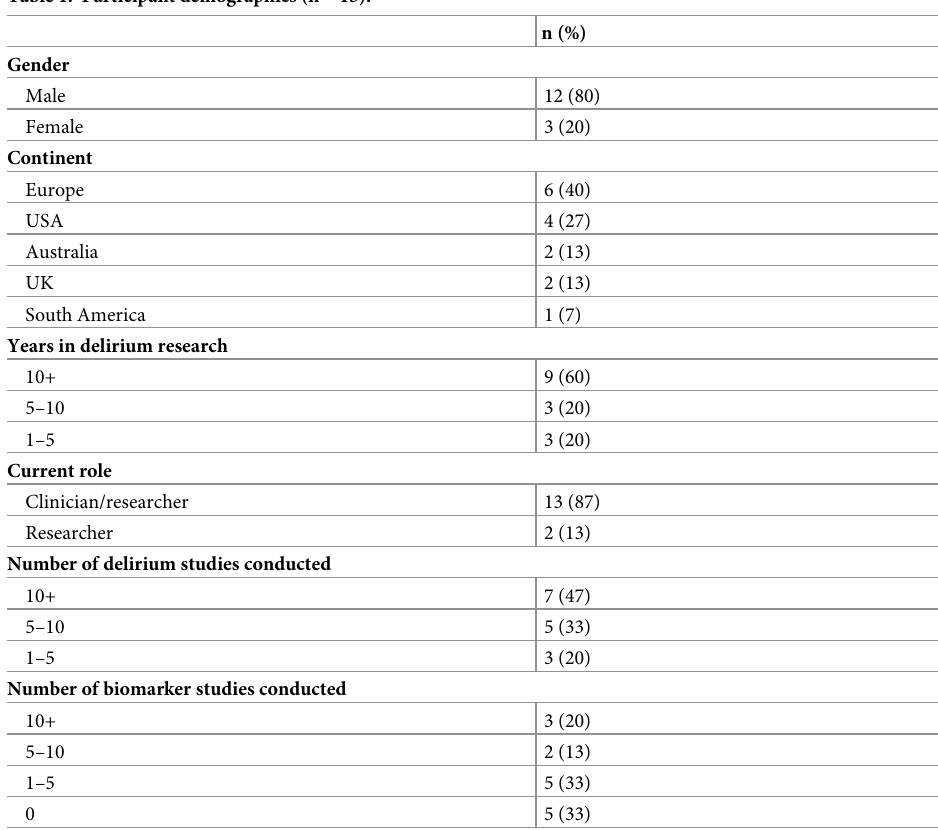
Table 1. Participant demographics (n =